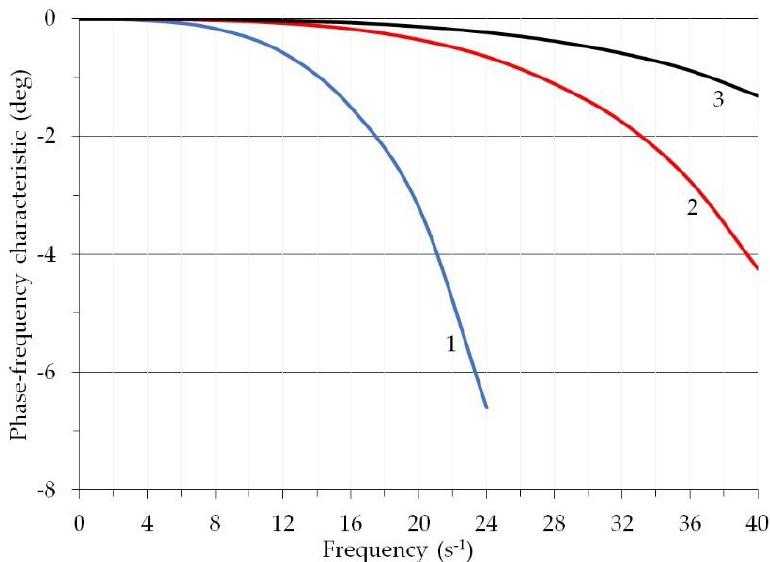
Figure 4. Phase–frequency characteristics of the dynamic system during the performance of the disturbance at different values of the tyre stiffness coefficient c of the tyre of harvester feeler wheels: curve 1, c = 115 kN m − 1 ; curve 2, c = 315 kN m − 1 ; curve 3, c = 515 kN m − 1